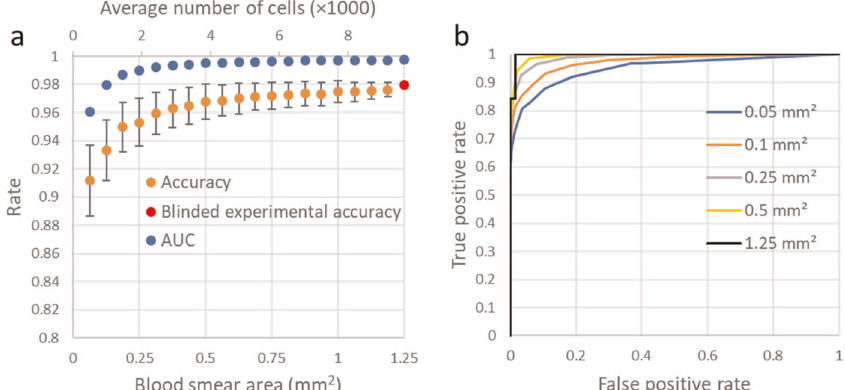
Fig. 4 Accuracy as a function of the number of cells counted. a Plot of how the accuracy and AUC change as a function the number of cells (and the blood smear area) inspected by our method. b ROC curves for various simulated blood smear areas. These plots (except the 1.25 mm 2 one, which is our experimental result) are based on the average of 1000 Monte Carlo simulations performed by removing the red blood cells from the imaging fi elds-of-view at random to change the number of cells inspected by our method. As the cells are relatively monodisperse, this random removal of the cells simulates a reduction in the inspected blood smear area per patient. Error bars represent the standard deviation (s.d.) across the 1000 Monte Carlo simulations.